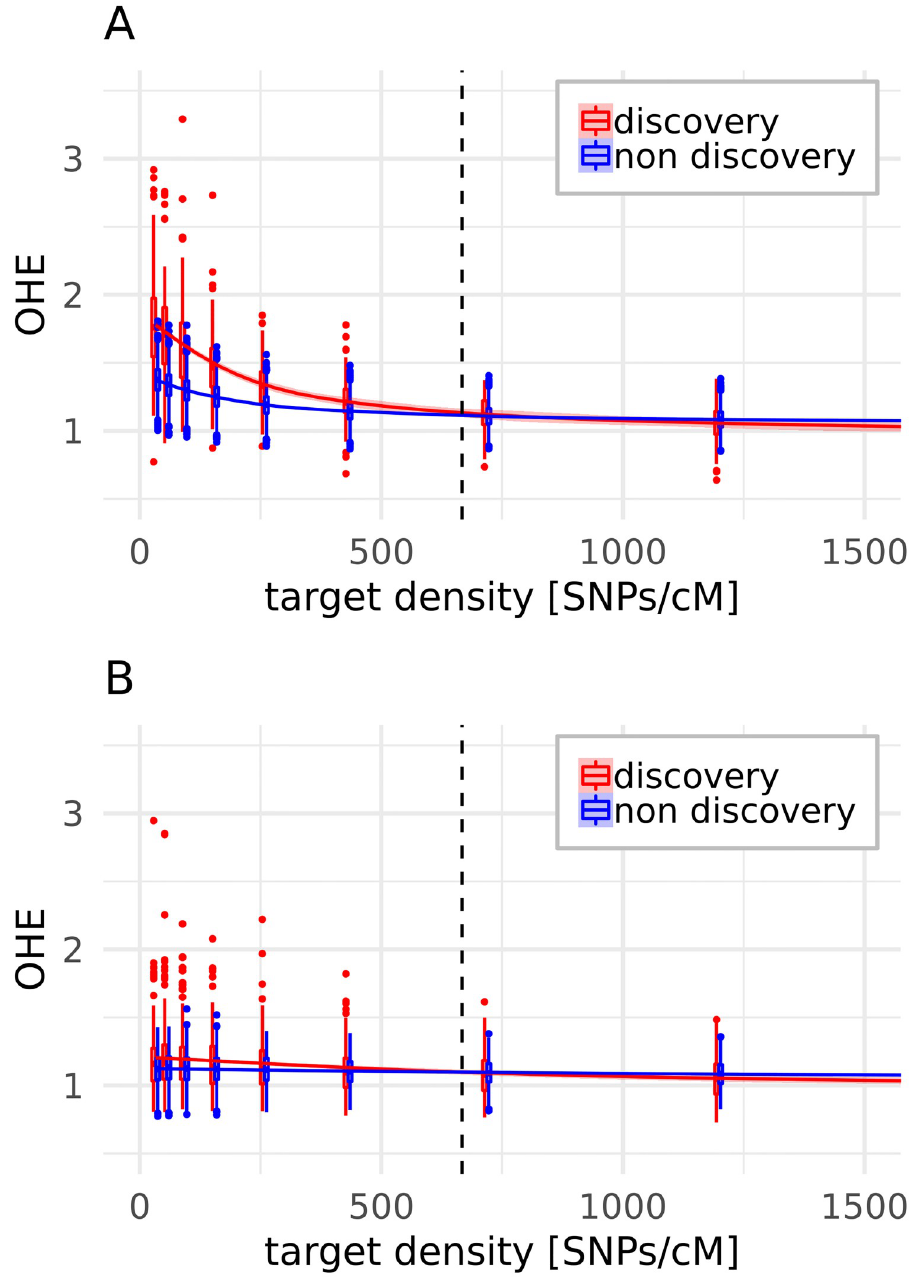
original array [21]. The algorithm was run including the initial backbone SNPs ( A ) or not including them ( B ). Gallus varius is not included, as it is constantly